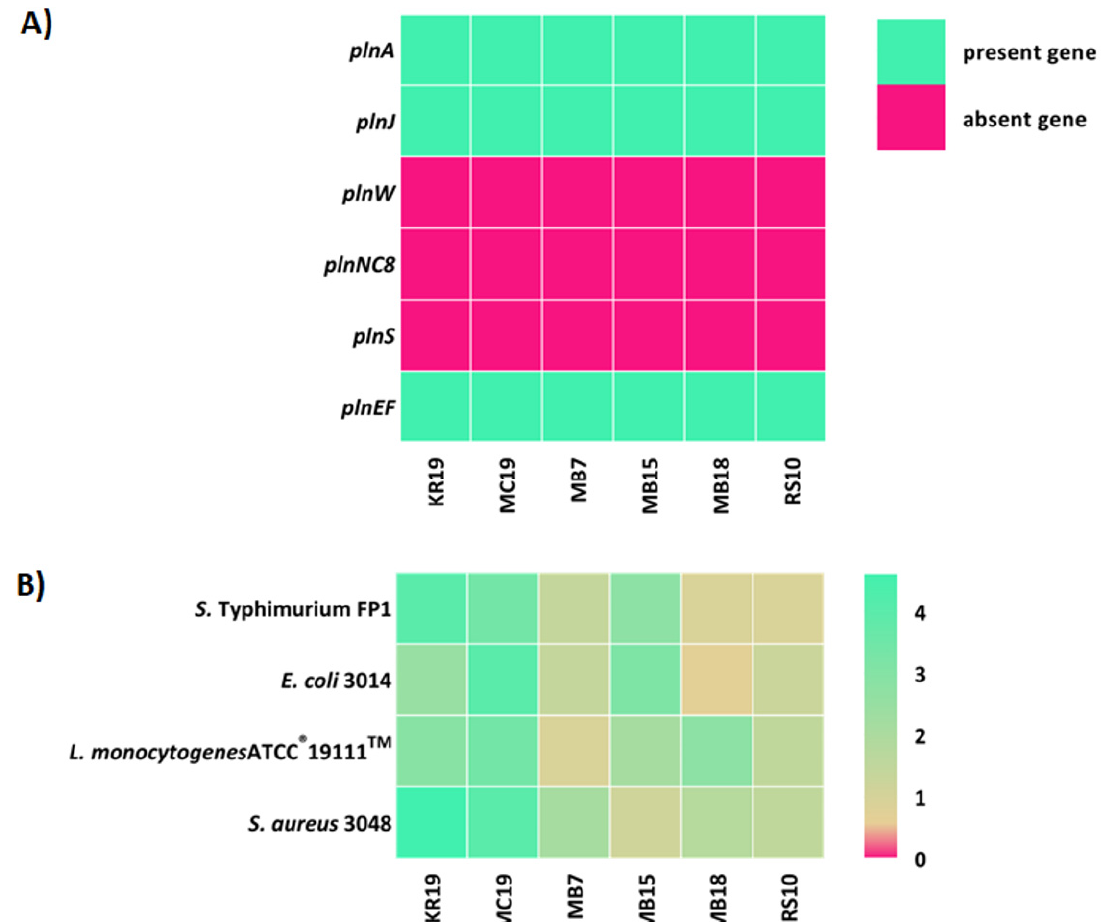
Figure 6. ( A ) Plantaricin-related genes of L. plantarum KR19, MC19, MB7, MB15, MB18 and RS10 strains detected by PCR with plantaricin structural gene-specific primers. ( B ) Heatmap comparison of antimicrobial activity of selected L. plantarum strains tested against potential pathogens using an agar spot-test, expressed as effective inhibition ratio (EIR). According to Coeuret et al. [23], EIR < 0.5 indicates weak inhibition; EIR > 1.5 strong inhibition, while values in between indicate medium inhibitory activity.